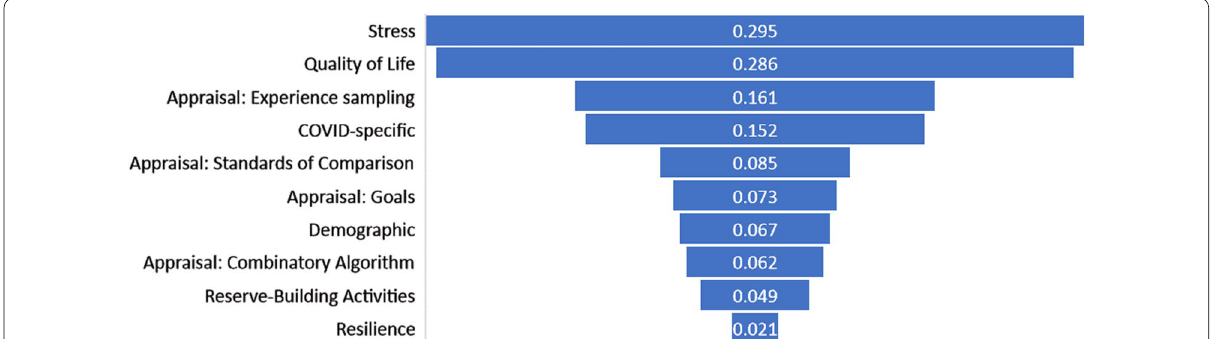
Fig. 1 Average explained variance by variable type. The most prominent variable types are shown in this funnel chart in order of average explained